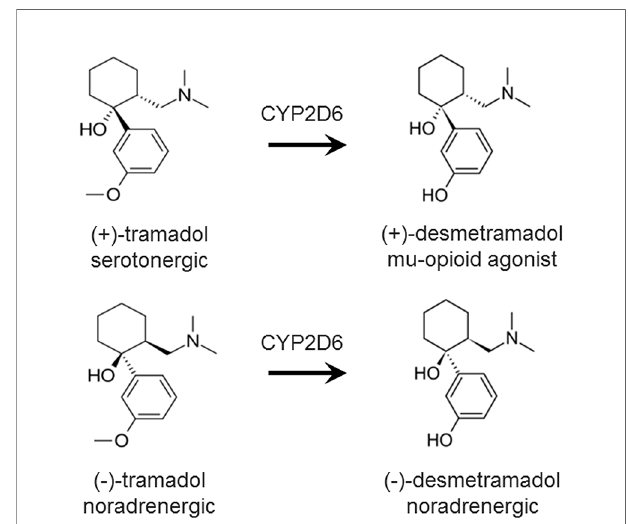
FIGURE 1 | Chemical structure and dominant pharmacology of each enantiomer of tramadol and desmetramadol. Desmetramadol is also known as M1 or O-desmethyltramadol. CYP2D6, cytochrome P450 isozyme